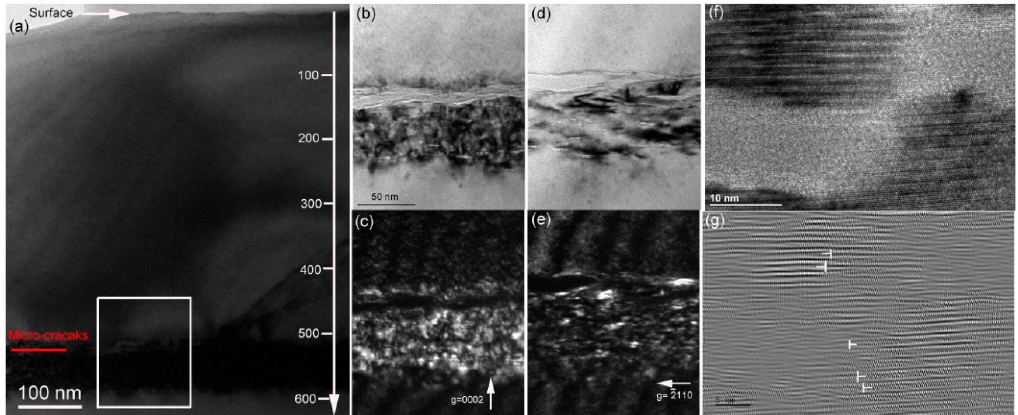
Figure 6. ( a ) Bright-field XTEM image showing the over-viewed damage distribution in the 194 keV H 2+ -implanted 6H-SiC at 450 °C followed by 1100 °C annealing for 15 min. The enlarged selected zone shown in ( a ) is presented in ( b – e ), where ( b ) BF and ( c ) WBDF images were observed under g = 0002, and ( d , e ) images were observed under g = 2110. ( f ) The high-resolution transmission electron microscope image shows the lattice fringe along the micro-crack, and ( g ) the inverse Fourier-filtered image of ( f ) shows interstitial-type dislocation loops on the (0001) plane. The scale in ( b ) is the same as that in ( c – e ).